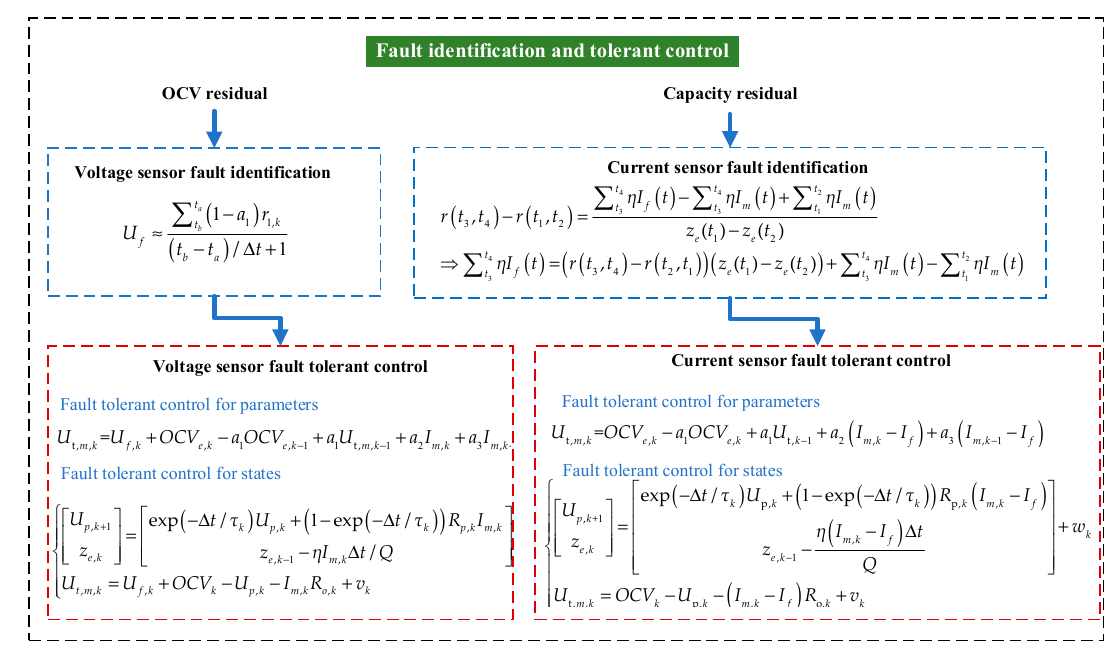
Figure 3. Senor fault identification and tolerant control.